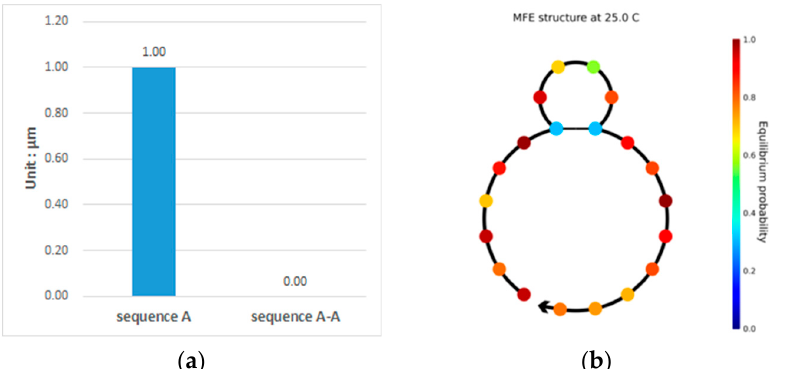
Figure 4. Analysis of the sequence TCTGTACTGCTGACTCGGGC. ( a ) Sequence species and con- centration present after the sequence enters the solution, including sequence A and sequence A-A obtained by the complementary pairing reaction after it enters the solution; ( b ) shows the secondary structure diagram of sequence A.